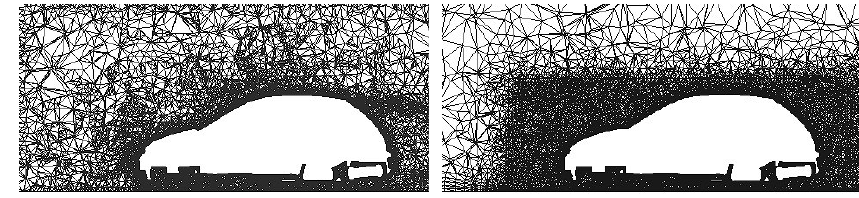
Figure 12 Impact of Local Refinement on Tetrahedral